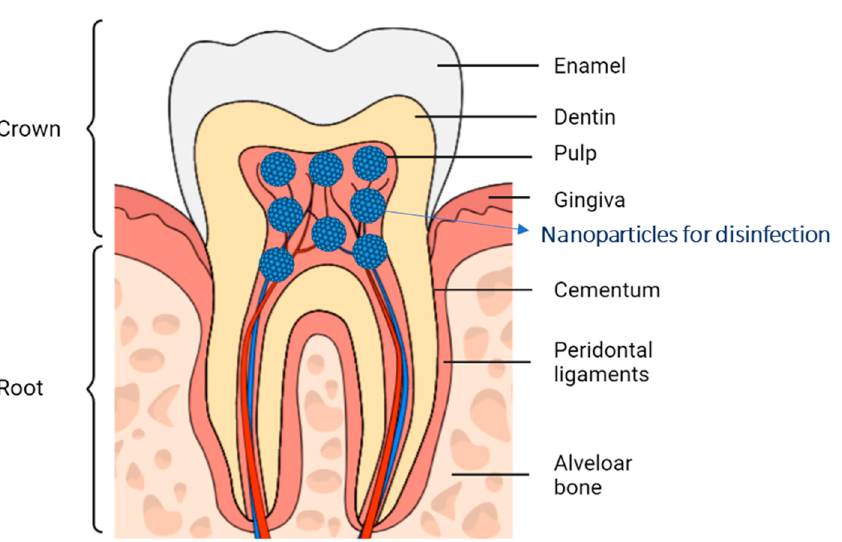
Figure 1. Tooth anatomy divided in crown and root and nanoparticles localization for endodontic disinfection [24,25]. disinfection